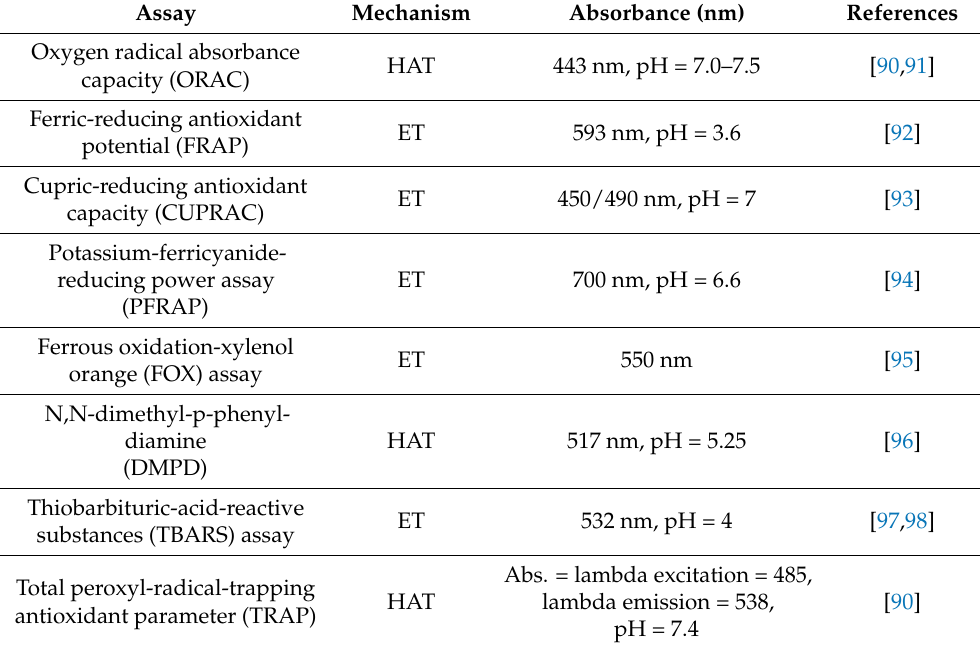
Table 3. Measurement of